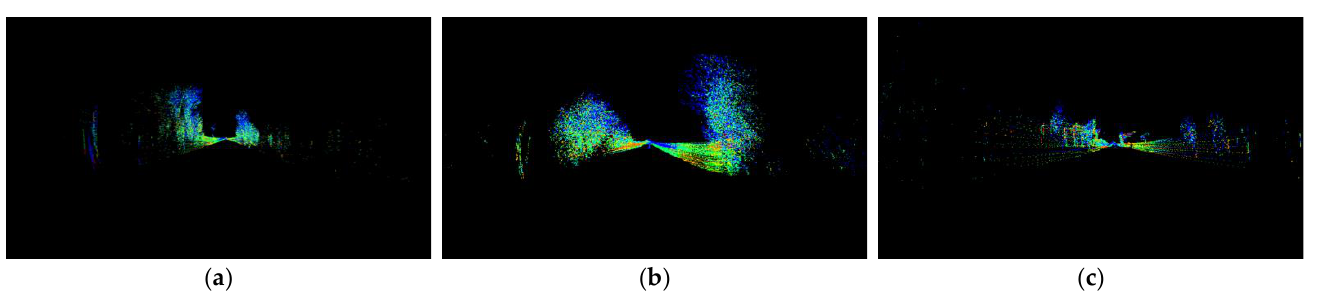
Figure 5. Point cloud image scene 1: Masonvale-fast-S16 ( a ) Picture 1, ( b ) Picture 2, ( c ) Picture 3.